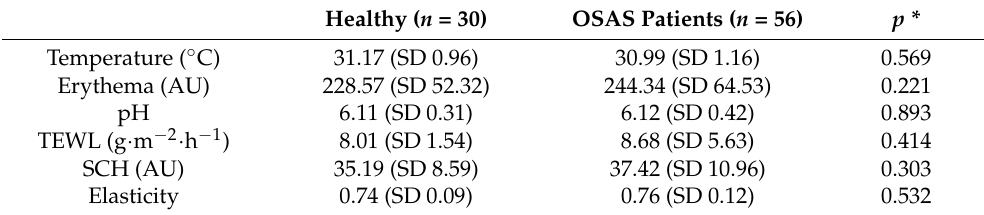
Table 2. Differences in skin barrier function between healthy individuals and patients with OSAS.